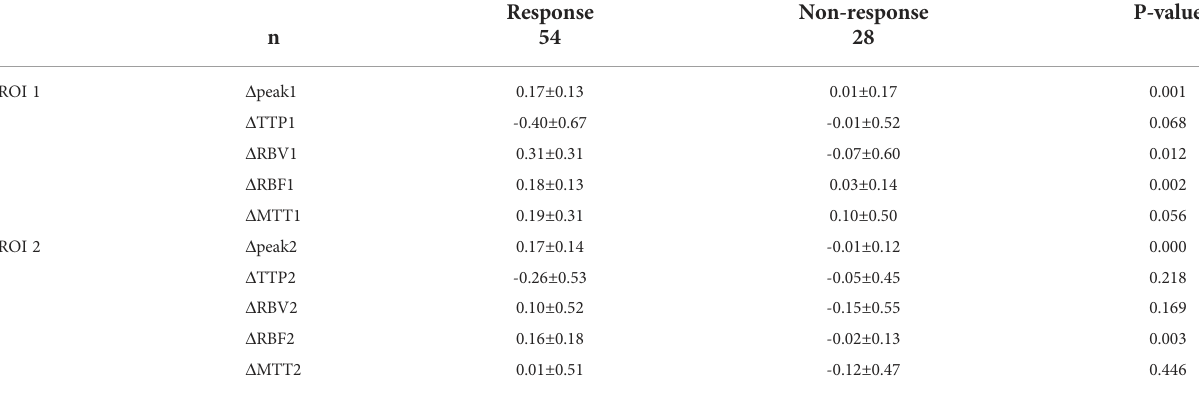
TABLE 2 TIC parameters in ROI 1 and ROI 2 after 1st Cycle of NAC for Discrimination between Responders and